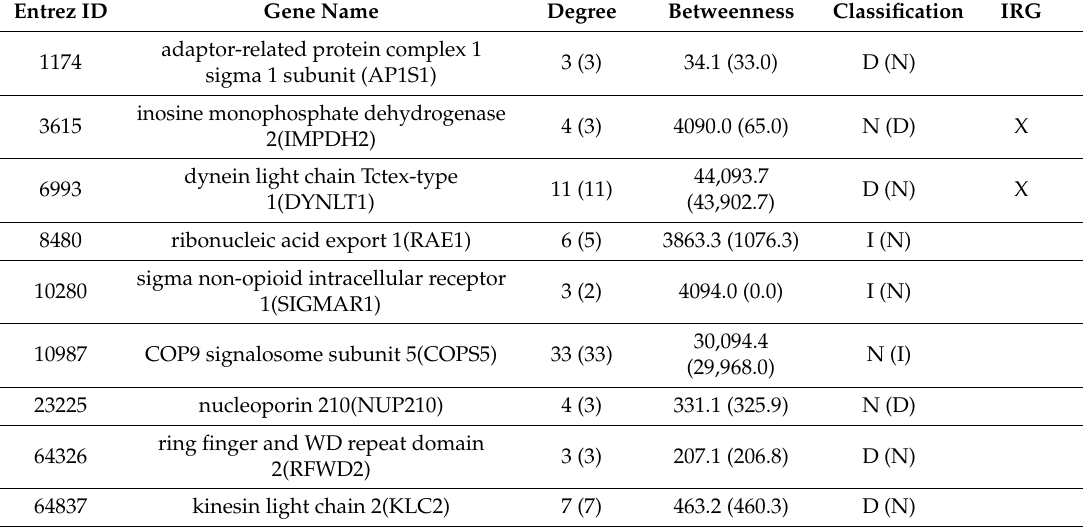
Table 3. The identities and topological characteristics of the proteins identified in the robust controllability analysis. Values for degree, betweenness, and classification are given as VIN (HIN). Classification is denoted as indispensable, I; neutral, N; and dispensable, D. Genes which have experimentally shown a fold change in expression greater than 2 during interferon knockdown studies are denoted as interferon regulated genes